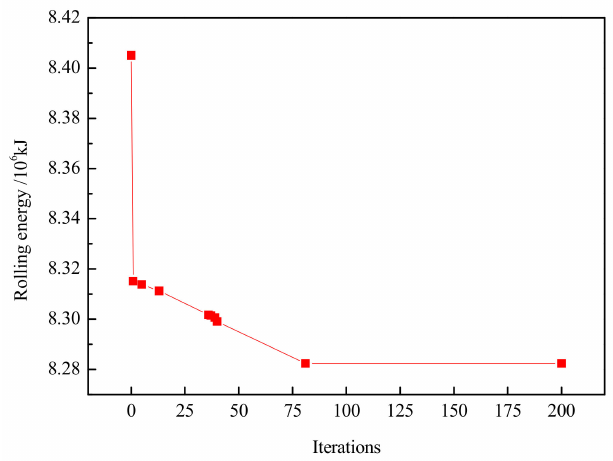
Figure 10. Convergence iterative curve for solving the multi-objective